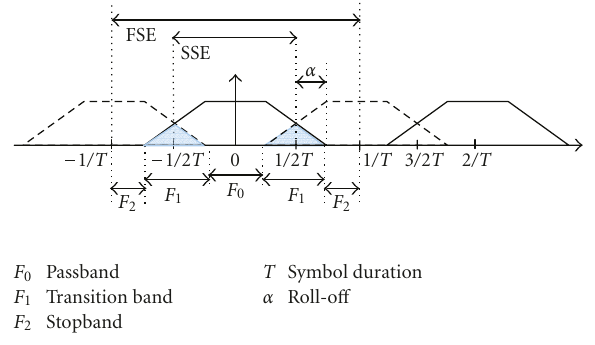
Figure 2: Signal spectra in the cases of SSE and FSE.